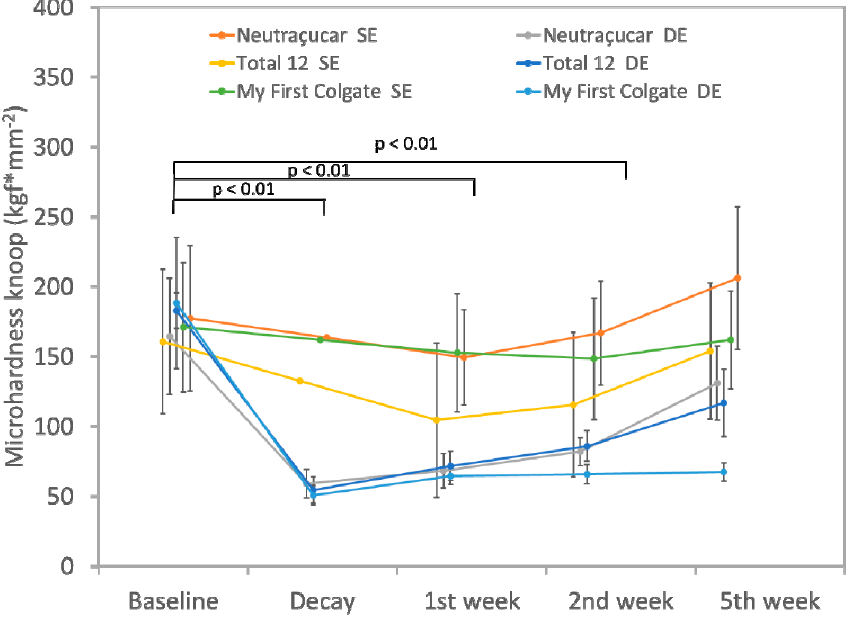
Figure 1. Means of Knoop microhardness of all groups. Error bars represent standard deviation.